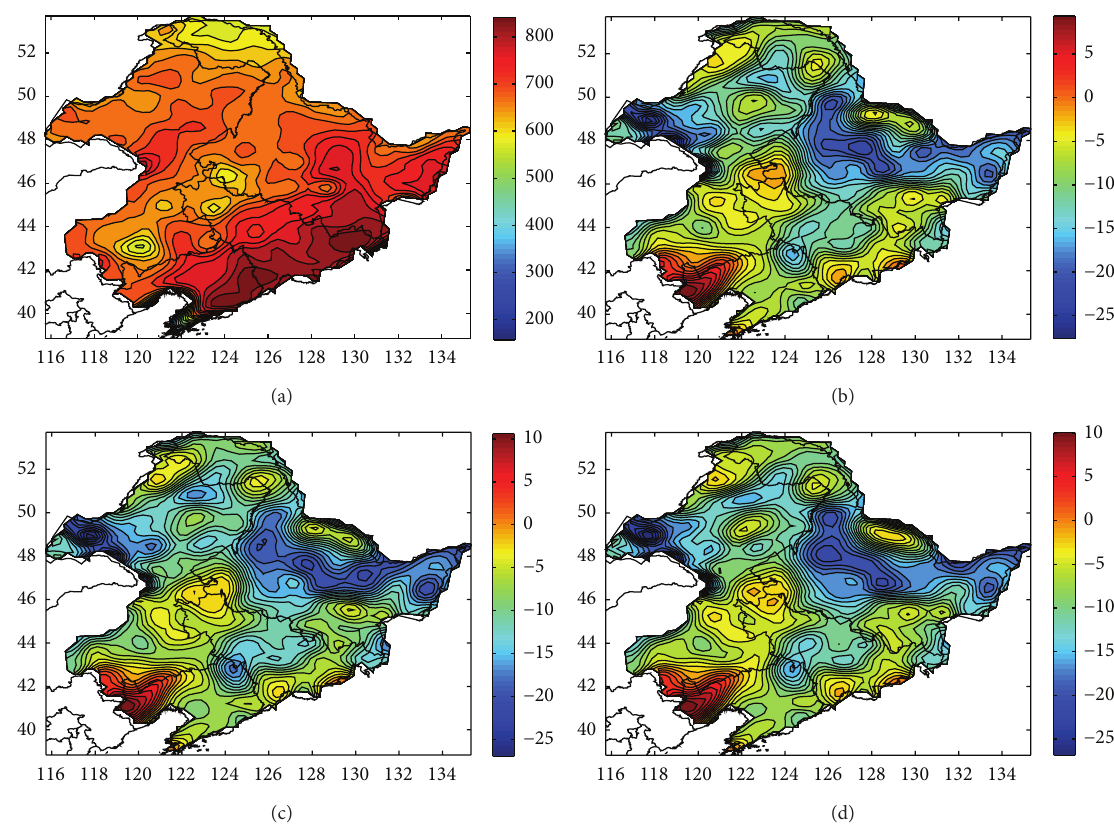
Figure 4: Difference between the sensible heat flux in Northeast China in 2010 and 2030 under different scenarios (unit: W/m 2 ). (a) Spatial pattern of the sensible heat flux in 2010; (b) difference of the sensible heat flux between 2010 and 2030 under the BAU scenario; (c) difference of the sensible heat flux between 2010 and 2030 under the REG scenario; (d) difference of the sensible heat flux between 2010 and 2030 under the CES